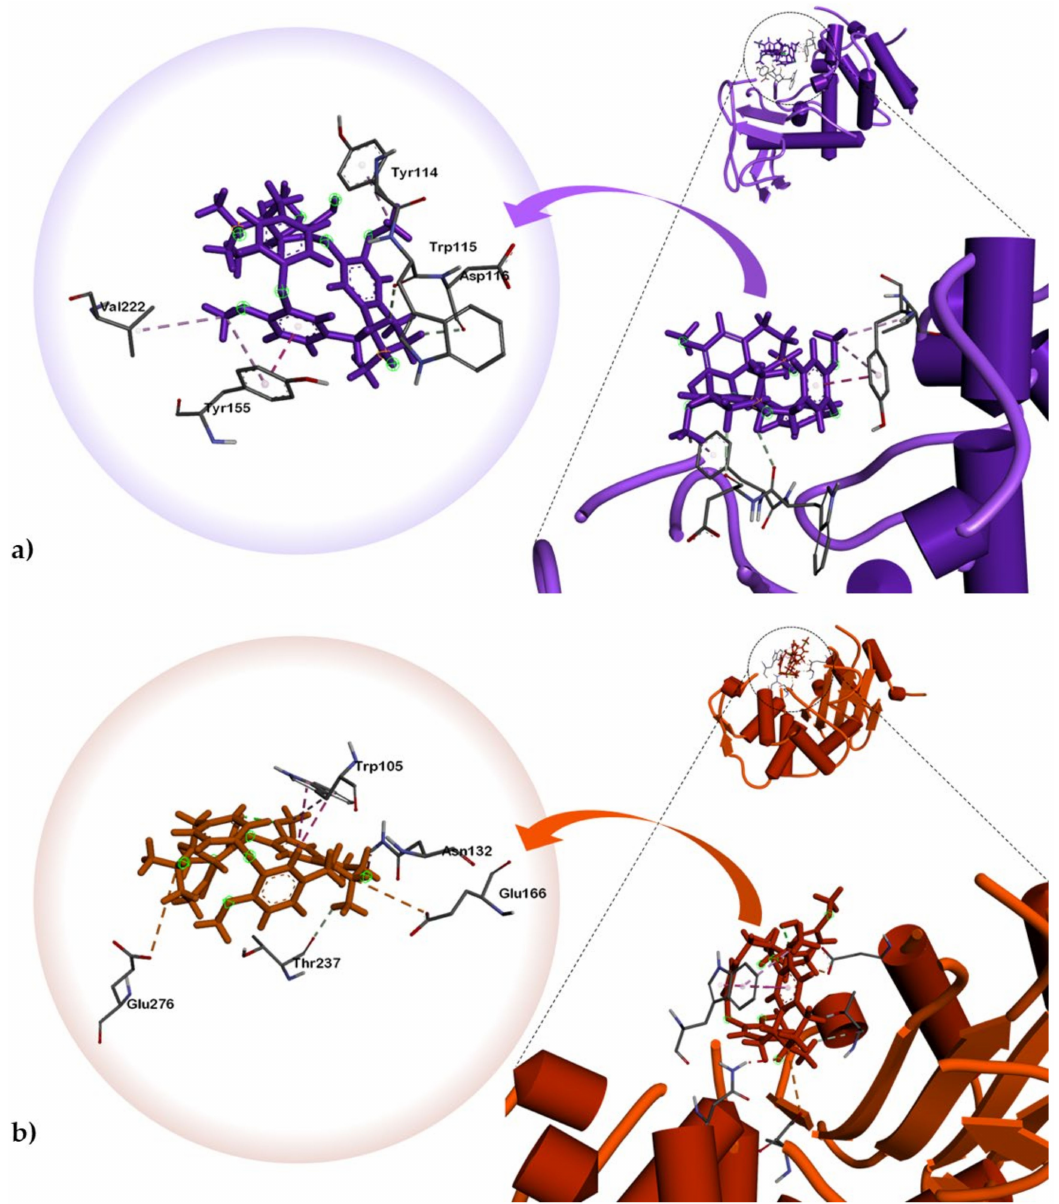
Figure 3. Dock poses of alkaloid 2 against ( a ) P. aeruginosa elastase (or LasB) (PDB ID: 1U4G), ( b ) K. pneumoniae KPC-2 carbapenemase (PDB ID: